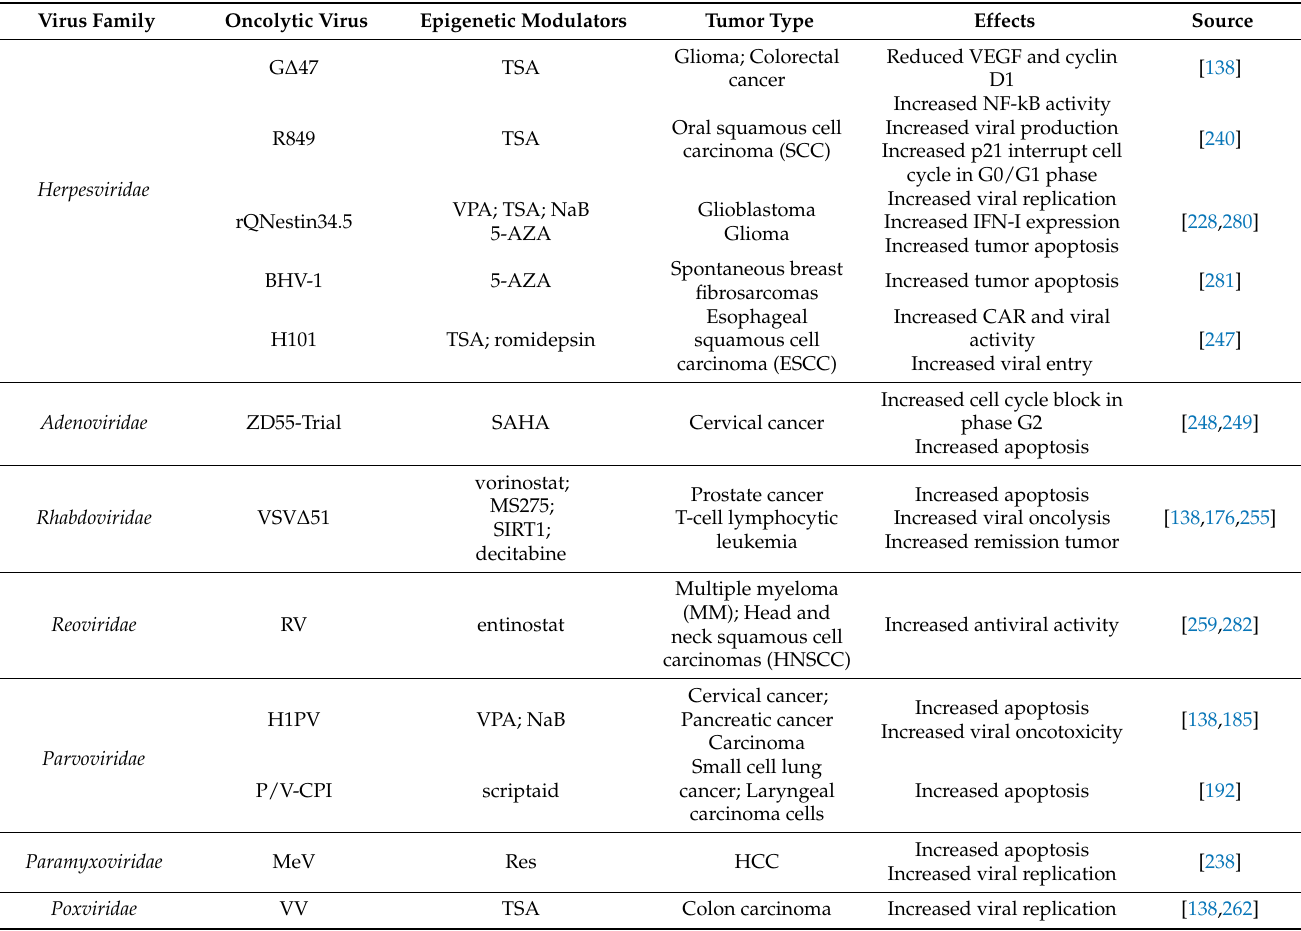
Table 2. Oncolytic virotherapy in combination with epigenetic modulators used in cancer therapy. It is indicated OV and epigenetic drug. In addition, the tumor type and the effect of the combinatorial treatment are reported. Virus